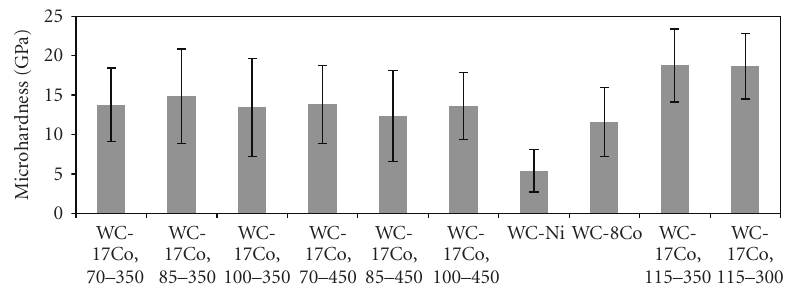
Figure 10: Microhardness of various WC-based coatings.